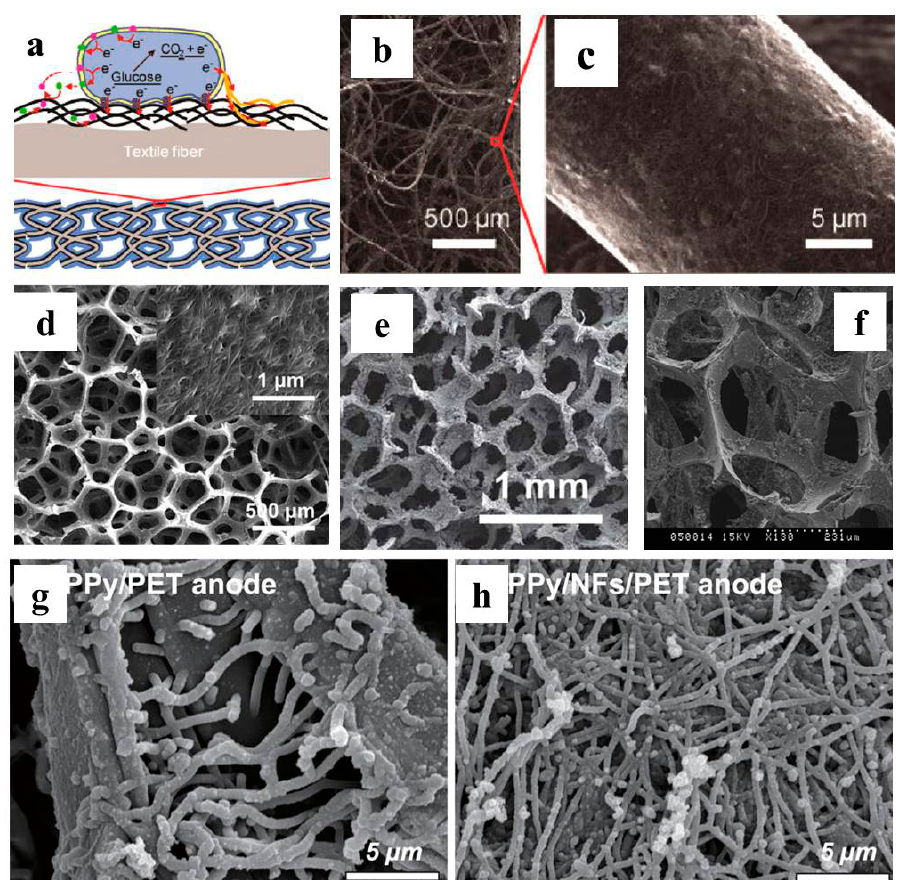
Figure 4. ( a ) Schematic of 3D CNT-textile electrode; SEM image of ( b , c ) textile fiber coated with CNT [88]; ( d ) CNT coated sponge [89]; ( e ) graphene coated sponge [90]; ( f ) nickel coated sponge [91]; ( g , h ) PPy coated PET and Nano fiber PET textile [123]. Reproduced with permission from American